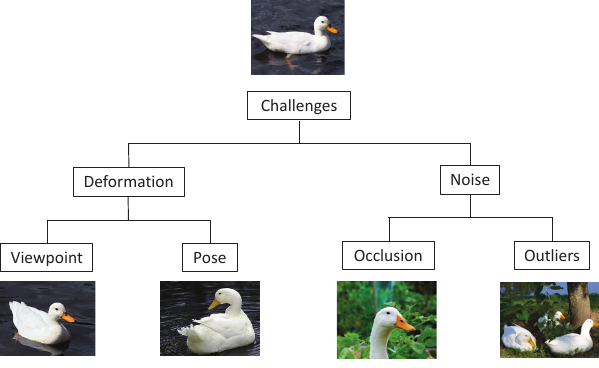
Figure 1. Some challenges in the point set registration [22].